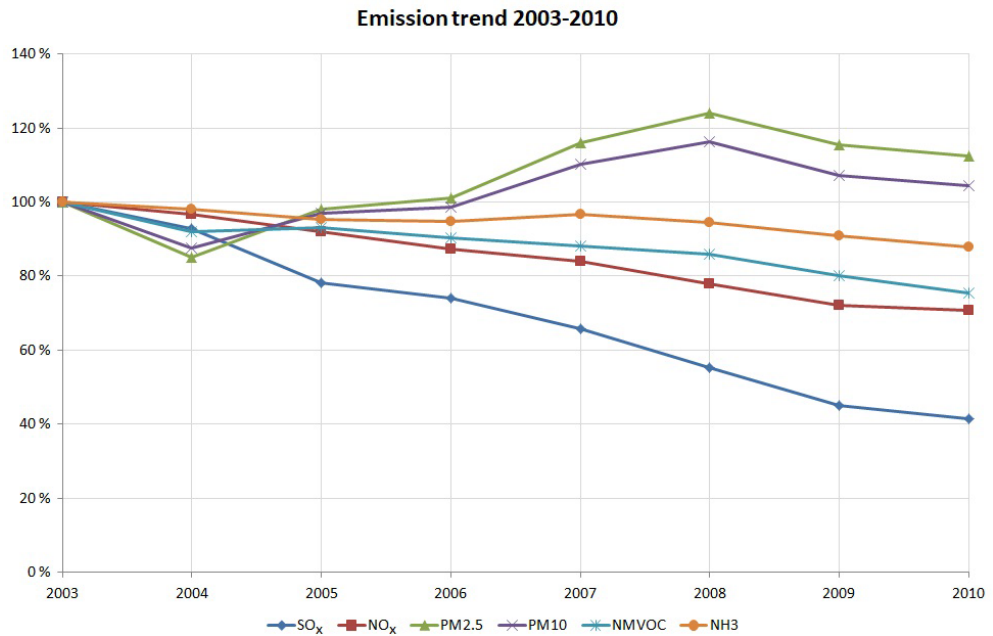
Figure 1. Italian anthropogenic emissions, from 2003 to 2010 relative to 2003, elaborated from the ISPRA emission data set described in Taurino et al.